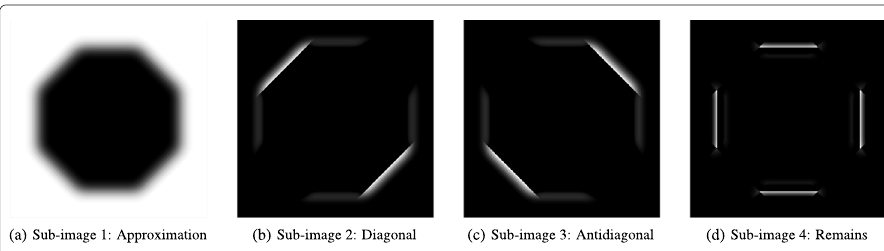
Fig. 9 Sub-images1–4 of the “Octagon” image processed with the “ SSA-iSBD4-channelfilterbank ,” type “ diagonal/antidiagonal ” with L = 30